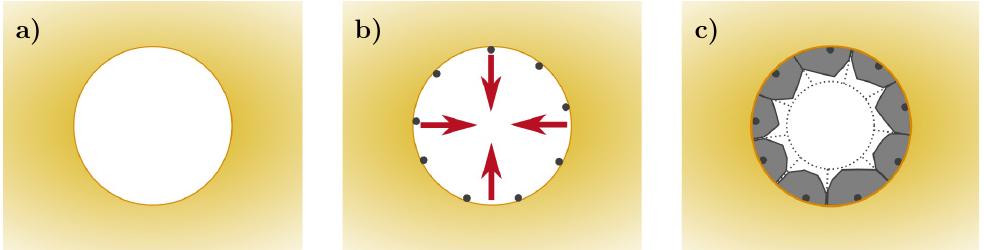
Fig. 5: Scheme of the radial metal growth. Cylindrical pore in the polycarbonate foil. a) Empty pore. b) Functionalized polymer surface through Pd-seeds on the pore walls. The arrows show the growth direction of the desired metal (Co, Ni). c) Metal grows radially from the pore interface inwards. The final states is indicated by the dotted